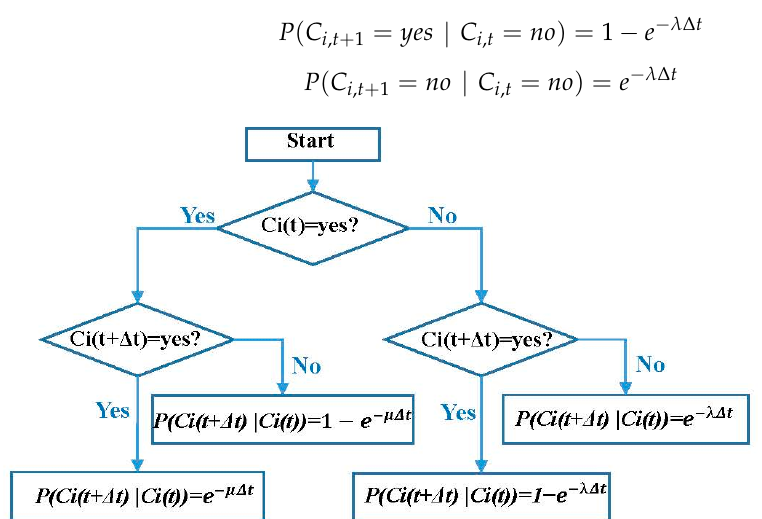
Figure 5. State transition diagram of two-state factors of sewage pump equipment. (ii)